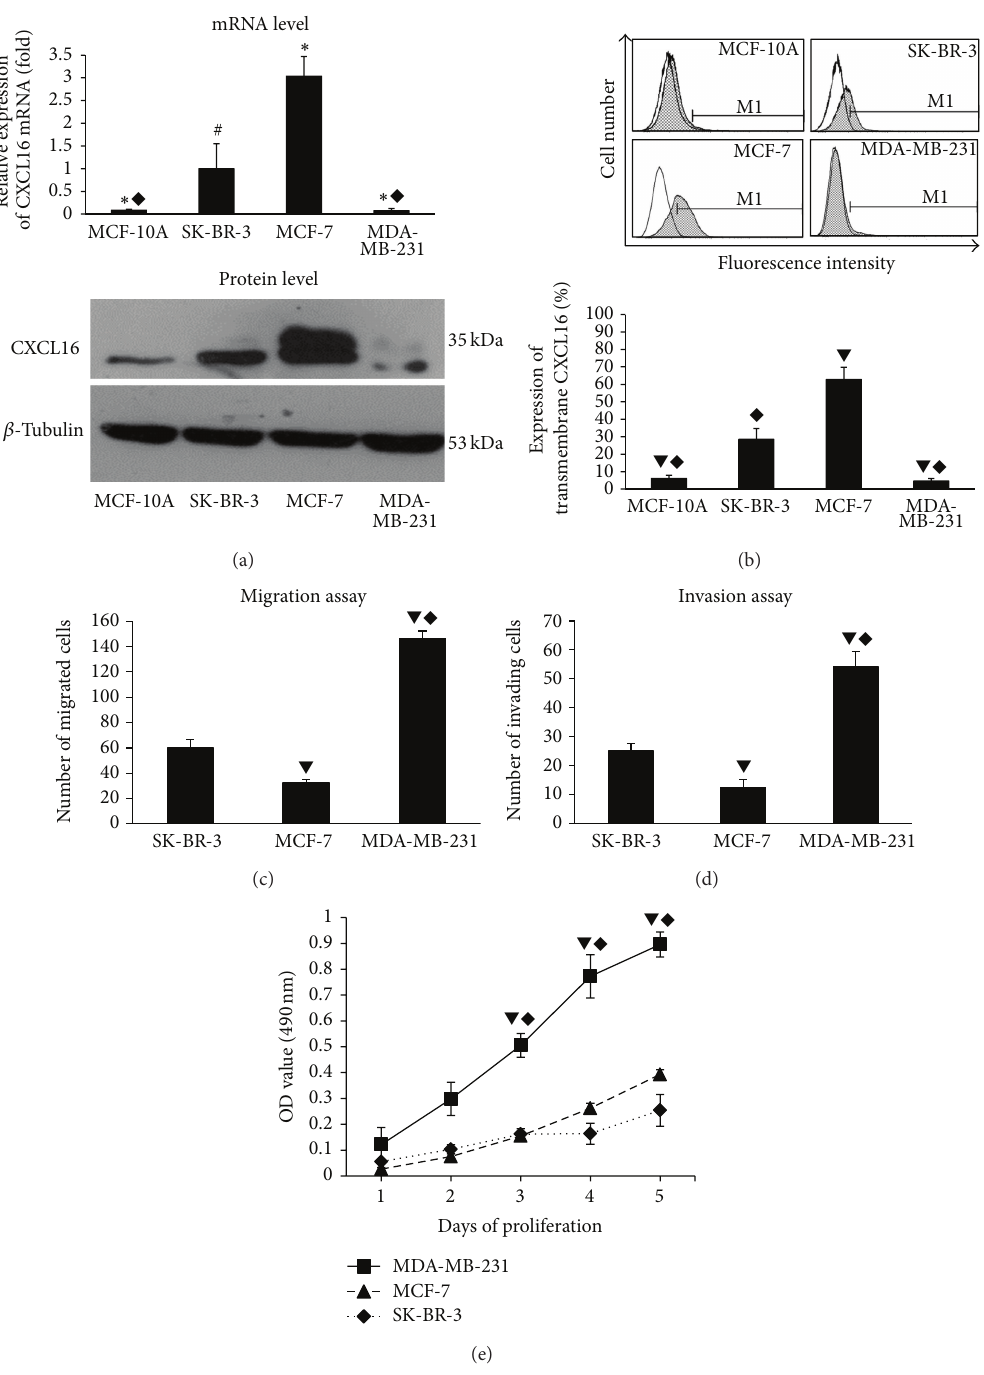
Figure 1: CXCL16 expression in breast cancer cell lines with diverse phenotypic characteristics. (a) CXCL16 mRNA and total protein were highest in MCF-7 and lowest in MDA-MB-231, while noncancerous human mammary epithelial cells MCF-10A faintly expressed CXCL16. ∗ 𝑃 < 0.05 compared with SK-BR-3. X 𝑃 < 0.01 compared with MCF-7. # 𝑃 < 0.05 compared with MCF-7. (b) TM-CXCL16 expression in breast cancer cell lines. MCF-7 cells expressed the most TM-CXCL16, while MDA-MB-231 cells barely expressed TM-CXCL16. 󳶃 𝑃 < 0.01 compared with SK-BR-3. X 𝑃 < 0.01 compared with MCF-7. (c) and (d) Migratory ability and invasiveness varied by breast cancer cell line. MDA-MB-231 possessed increased migratory ability and invasiveness, while MCF-7 was weakest. 󳶃 𝑃 < 0.01 compared with SK-BR-3. X 𝑃 < 0.01 compared with MCF-7. (e) Proliferation of three breast cancer cell lines. MDA-MB-231 proliferated fastest; no difference was observed between SK-BR-3 and MCF-7. 󳶃 𝑃 < 0.01 compared with SK-BR-3. X 𝑃 < 0.01 compared with